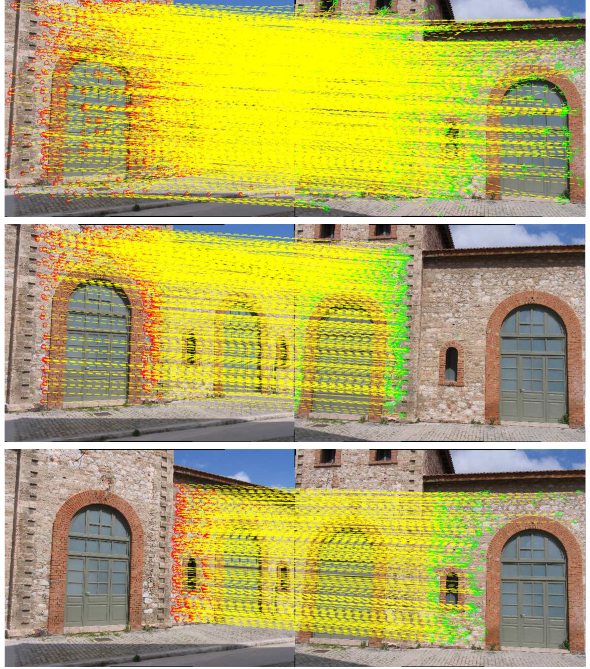
Figure 3. Top row: initial SURF matches (1718). Middle row: filtered points of the dominant plane (602). Bottom row: filtered points of the next-dominant plane